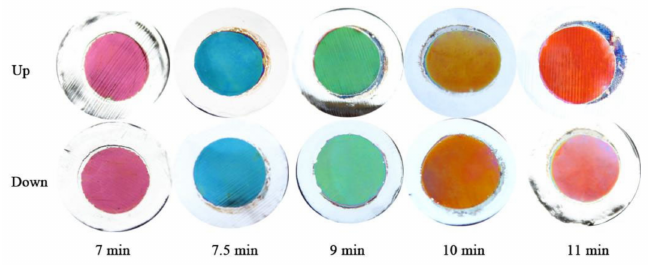
Figure 2. Digital images of twin alumina-Co composite films oxidized with a voltage of 20 V for 7, 7.5, 9, 10, and 11 min and deposited with voltage of 12 V for 5 s without applying deflecting electric field.